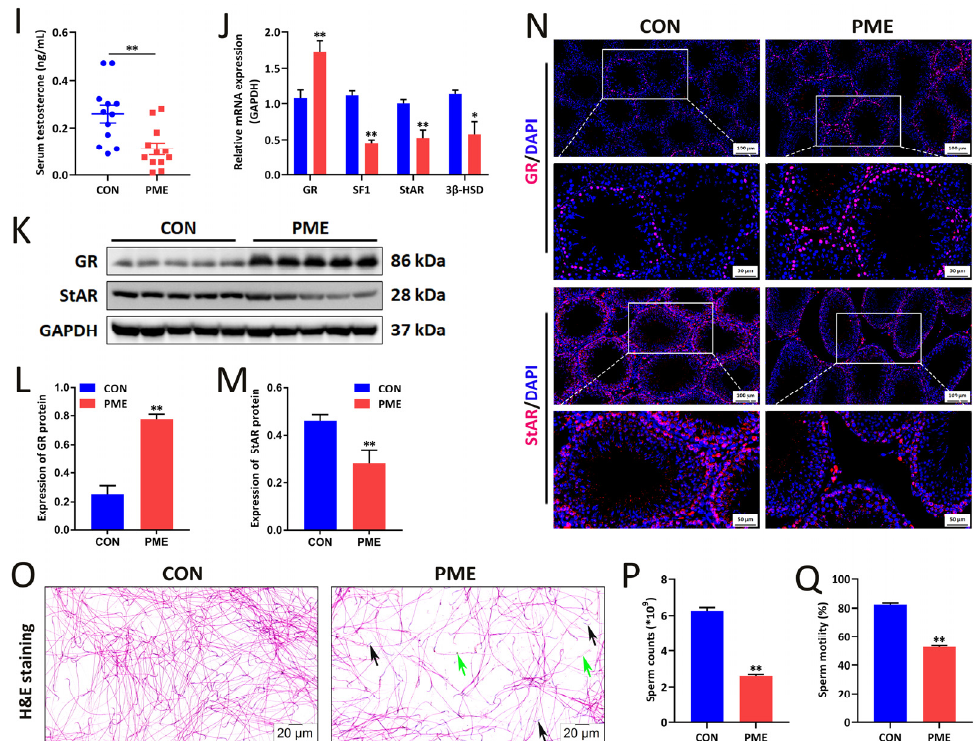
Figure 2. Paternal HPA axis function changes induced by nicotine/ethanol/caffeine exposure. ( A ) Body weight. ( B ) Serum adrenocorticotropic hormone (ACTH) content. ( C ) Serum corticosterone content. ( D ) StAR, 3 β -HSD, P450c21, and P450c11 mRNA expression in paternal adrenal tissue. ( E ) Morphological appearance of the testis. ( F ) H&E staining of testis (the red arrows indicate pathological changes). Original magnification: 100 × (scale bar: 100 µ m); 200 × (scale bar: 50 µ m). ( G ) Testicular weight; ( H ) Testicular tube diameter; ( I ) Serum testosterone content. ( J ) StAR, 3 β -HSD, and P450scc mRNA expression in testis. ( K – M ) Representative immunoblot images of GR and StAR protein expression in testis ( K ) and densitometric analysis ( L , M ). ( N ) Representative images of immunofluorescence assay of GR and StAR in testis sections. Original magnification: 100× (scale bar: 100 μ m); 200× (scale bar: 50 μ m). ( O ) H&E staining of sperm (green arrow: headless sperm; black arrow: tailless sperm). Original magnification: 400×; scale bar: 20 μ m. ( P ) Sperm counts. ( Q ) Sperm mobility. Means ± S.E.M, * p < 0.05, ** p < 0.01 vs. CON (control), n = 10 for RT-qPCR analysis and serum biochemical detection; n = 5 for Western bolt analysis.